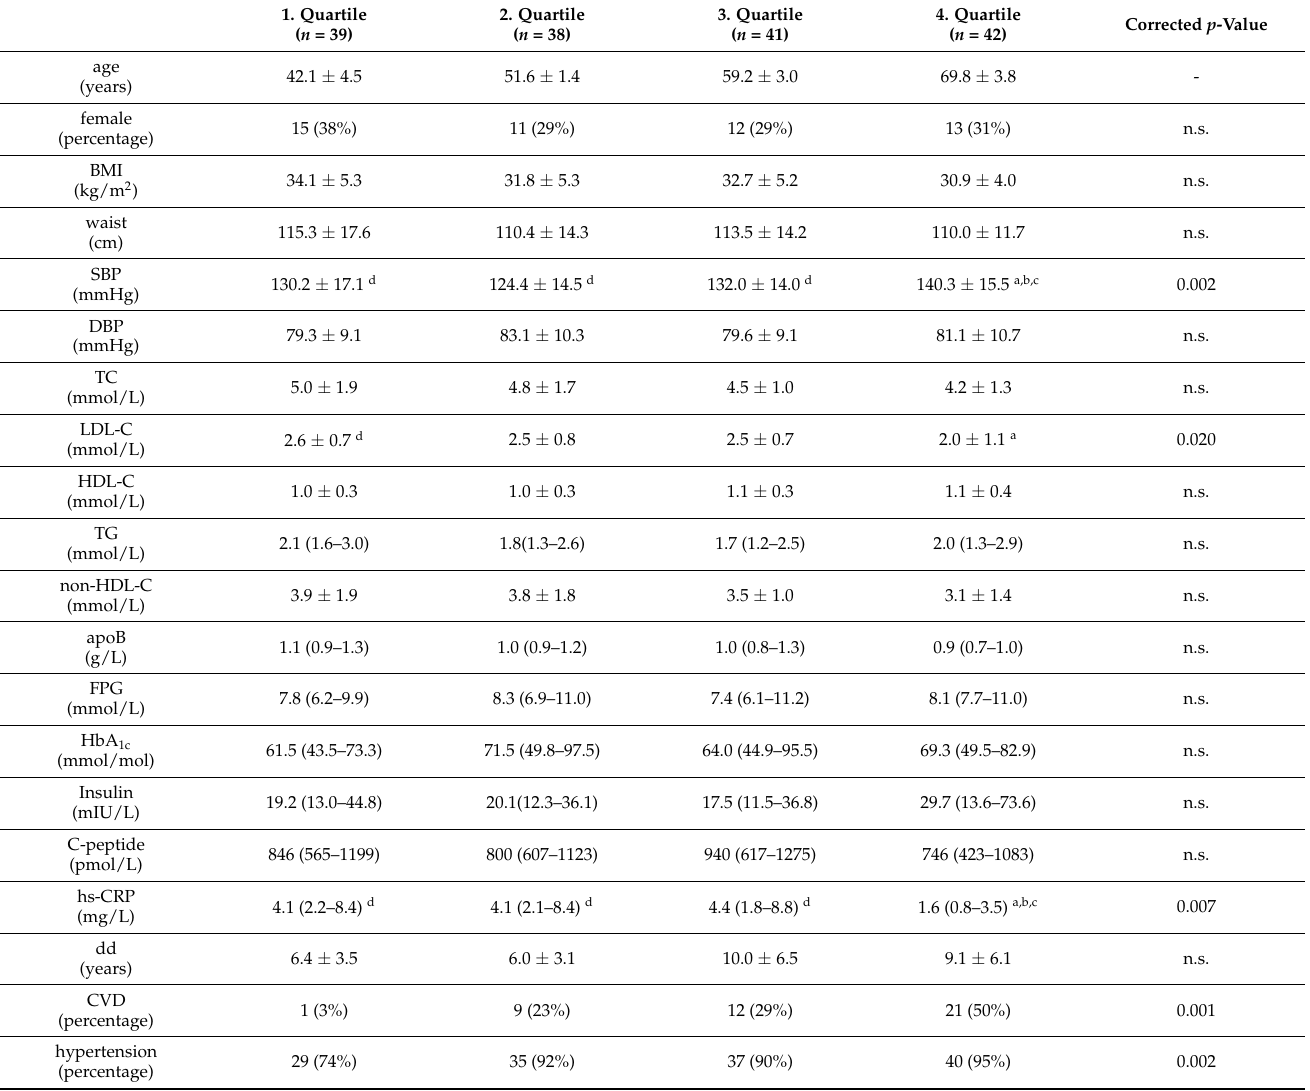
Table 1. Basic clinical and laboratory characteristics in individual quartiles according to